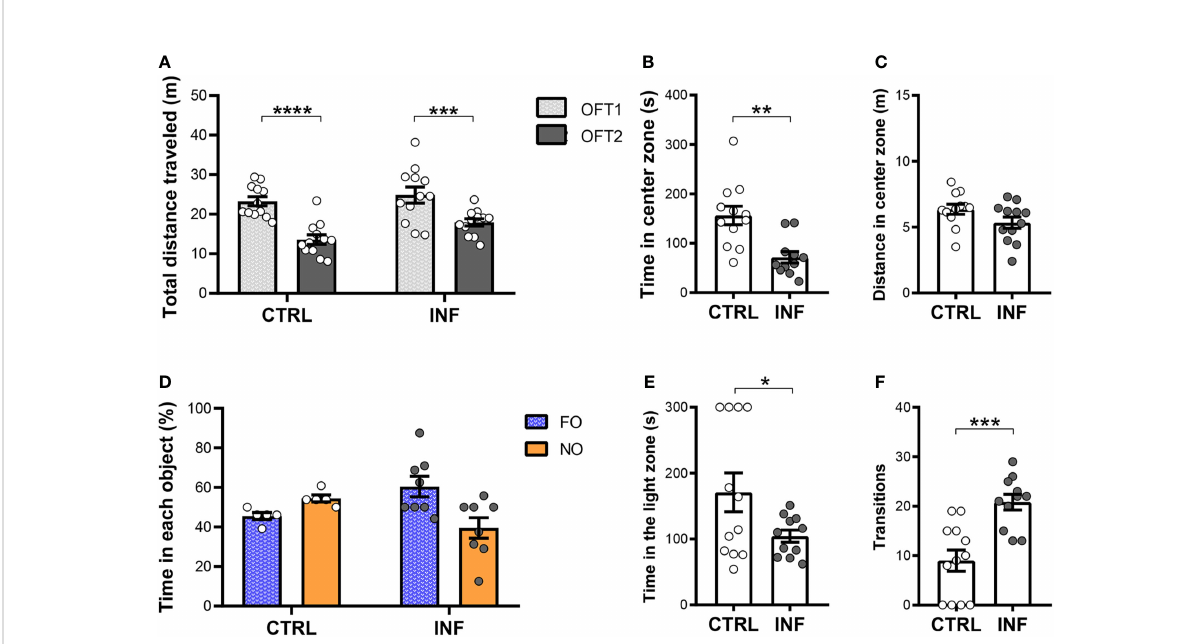
FIGURE 4 Effect of non-severe Plasmodium berghei ANKA infection in mice in behavioral performance in different paradigms 145 days after the end of treatment (dpt). (A) Total distance traveled in meters (m) in open fi eld test (OFT1 and OFT2) 50 × 50 × 50 cm arena. (B) Time in center zone (seconds, s). (C) Distance in center zone (m) in fi rst session of OFT. (D) Time in objects in percentage (%) in test session in the NORT. (E) Time in the light zone (s). (F) Numbers of transitions between light and dark side in light/dark task. CTRL (control) and INF (infected and treated) mice groups. Data points are identi fi ed as individuals ’ values. Columns represent mean ± S.E.M. Two-way RM ANOVA/Bonferroni was used for intragroup comparison of different sessions (n=12/group) and different objects (n=5-8/group). Two-way ANOVA was used for comparison between CTRL